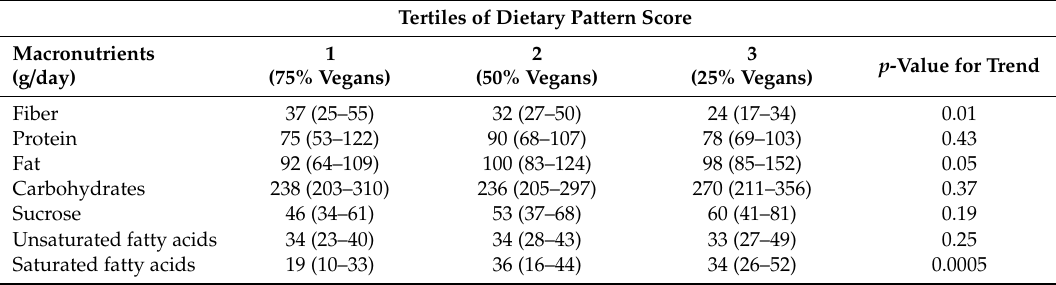
Table 3. Intake of macronutrients according to tertiles of the first dietary pattern. Tertiles of Dietary Pattern